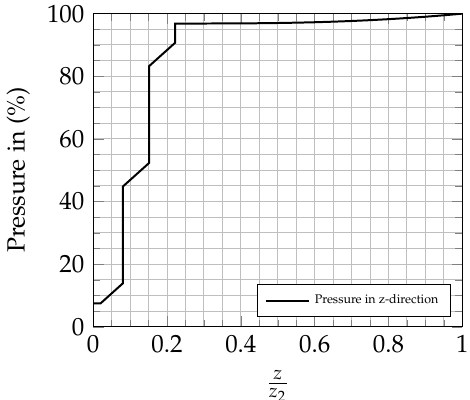
Figure 21. Pressure function at the runner shroud in z -direction of hydropower plant